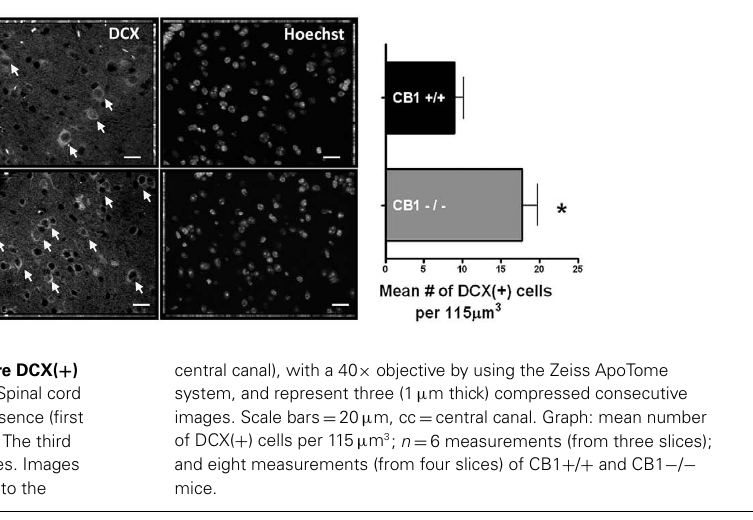
central canal), with a 40 × objective by using the Zeiss ApoTome system, and represent three (1 μ m thick) compressed consecutive images. Scale bars = 20 μ m, cc = central canal. Graph: mean number of DCX( + ) cells per 115 μ m 3 ; n = 6 measurements (from three slices); and eight measurements (from four slices) of CB1 + / + and CB1 − / −